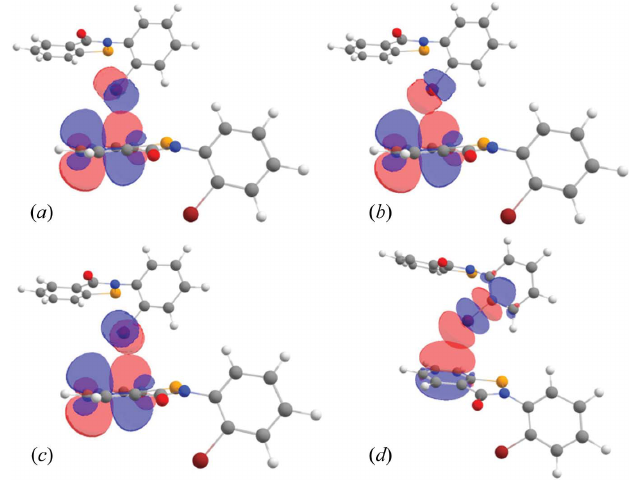
Figure 8 ( a ), ( b ), ( c ) Inter-orbital interactions between three different lone pairs of Br with (cid:3) *(C—C). ( d ) The inter-orbital interaction between (cid:3) (C—C) and (cid:2) *(Br—C). Blue and red depict positive and negative lobes,